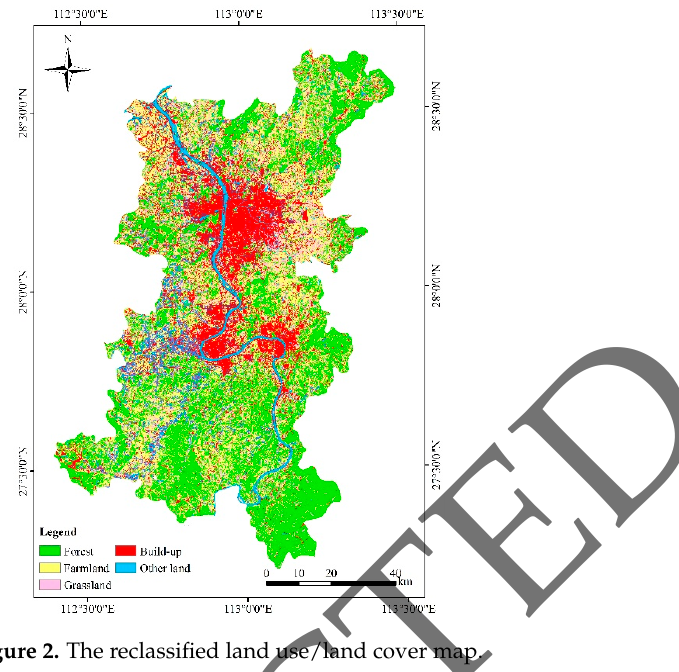
Figure 2. The reclassified land use/land cover map.